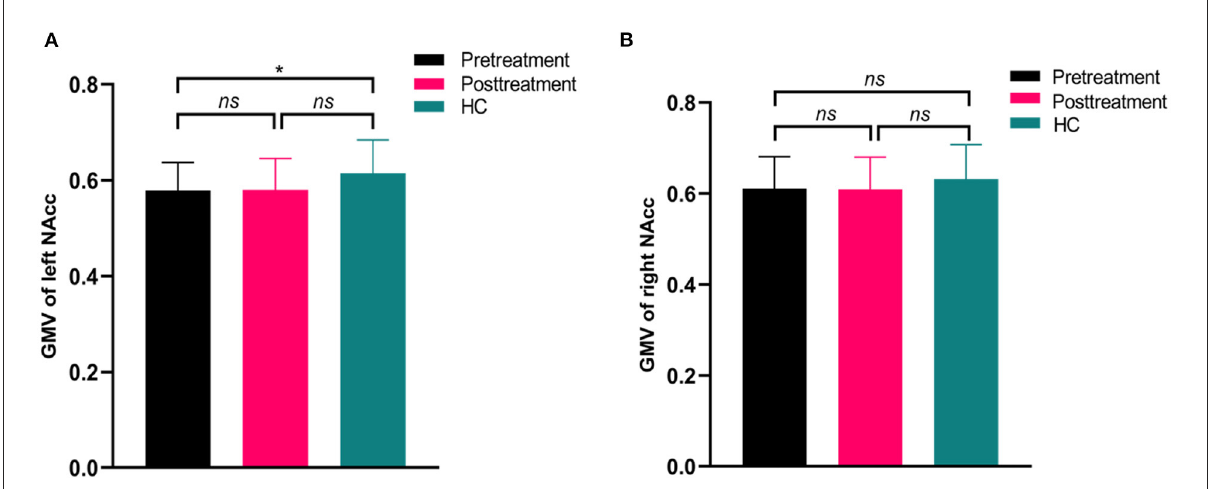
FIGURE4 Differences in gray matter volume (GMV) of nucleus accumbens between patients (pretreatment and posttreatment) and healthy controls (HC). The pretreatment patients showed significantly decreased GMV in the left nucleus accumbent compared to HC (A) . While there were no significant differences in the right nucleus accumbens between patients (pretreatment and posttreatment) and HC (B) . * p > 0.05; ns, no